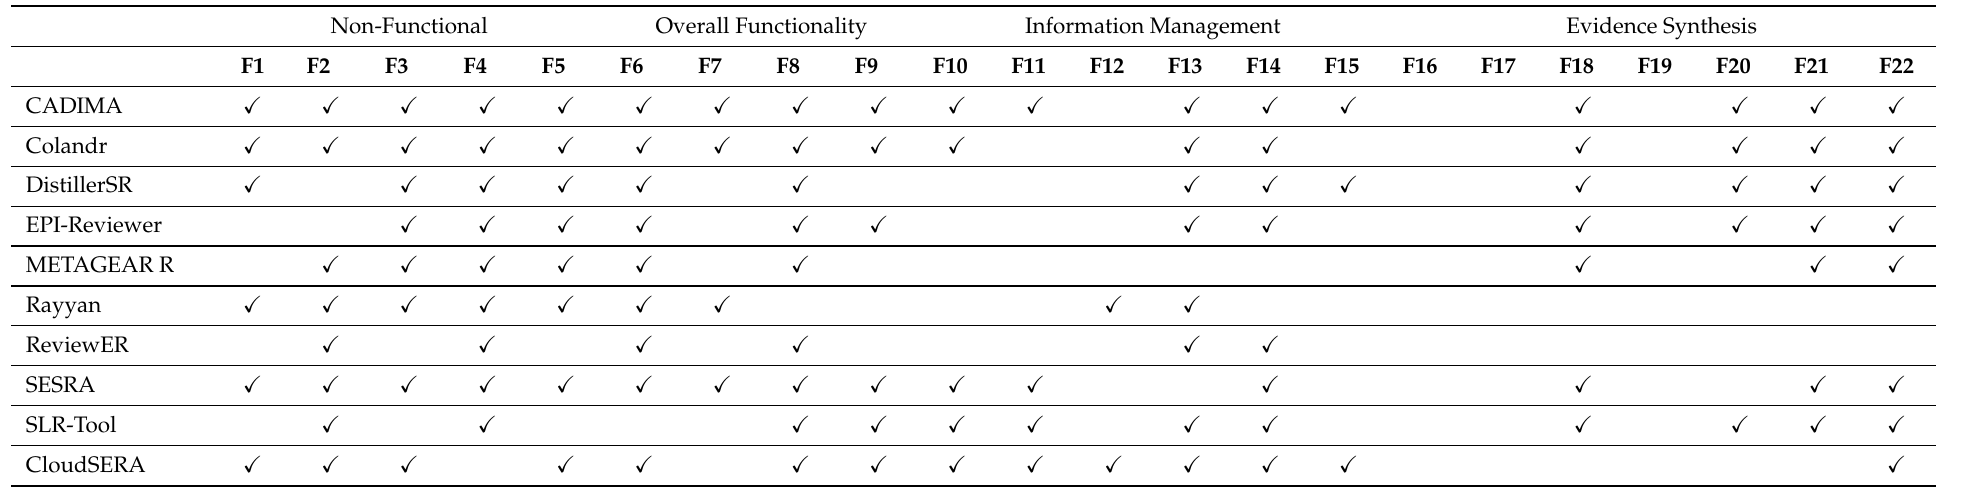
Table 2. Analysis of main desirable features in existing SR